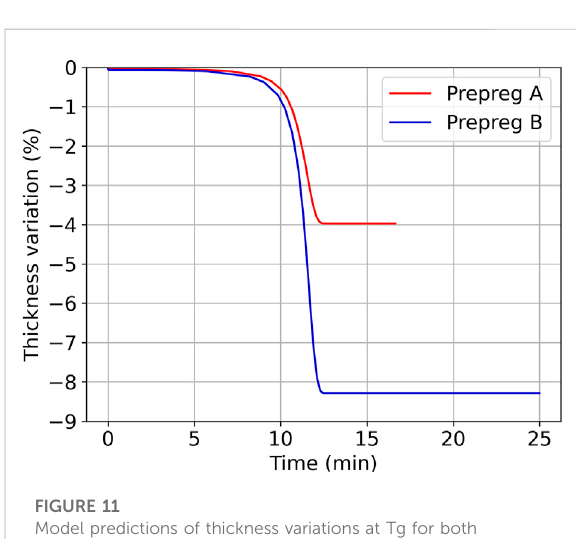
FIGURE 11 Model predictions of thickness variations at Tg for both prepregs with 10%-crystallinity